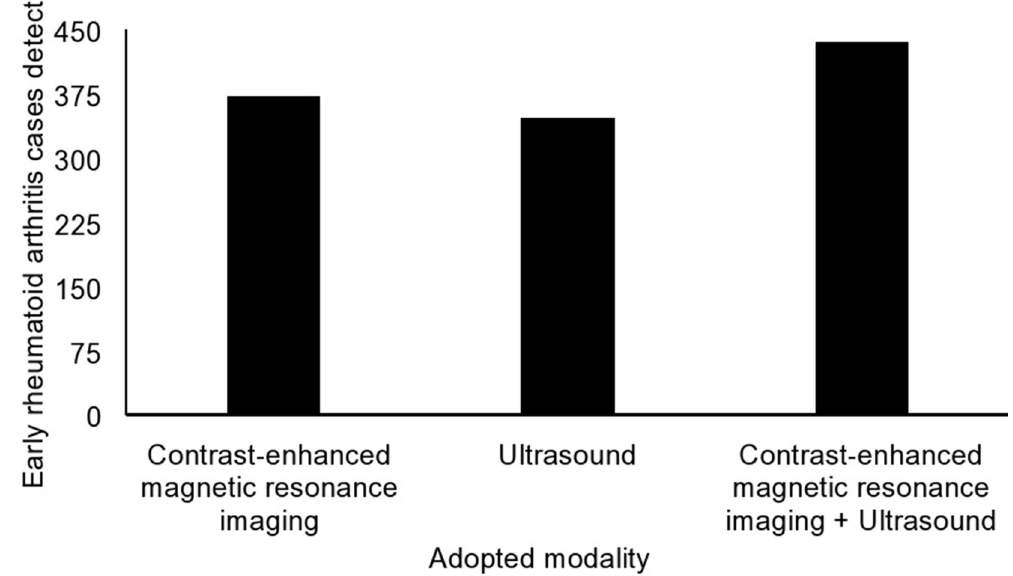
Data are represented as a number (percentage).